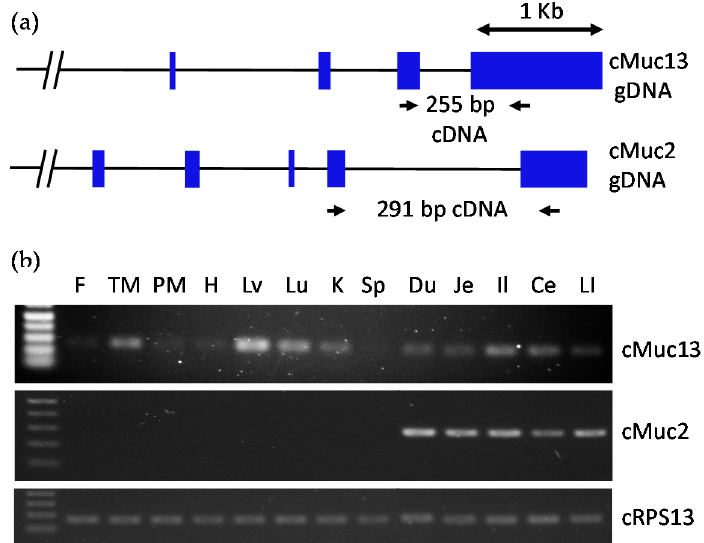
Figure 1. ( a ) Schematic exon-intron diagram of chicken MUC13 and MUC2 genes. Locations of inter-exon primers for RT-PCR are marked with arrows and expected sizes of amplified PCR products are indicated. Blue boxes represent exons; ( b ) RT-PCR tissue distribution including fat (F), thigh muscle (TM), pectoralis muscle (PM), heart (H), liver (Lv), lung (Lu), kidney (K), spleen (Sp), duodenum (Du), jejunum (Je), ileum (Il), cecum (Ce), and large intestine (LI). MUC13 was expressed in numerous tissues outside of the intestinal tissue. MUC2 was indicated to be intestine-specific, and chicken ribosomal protein s13 (cRPS13) was used as a control.